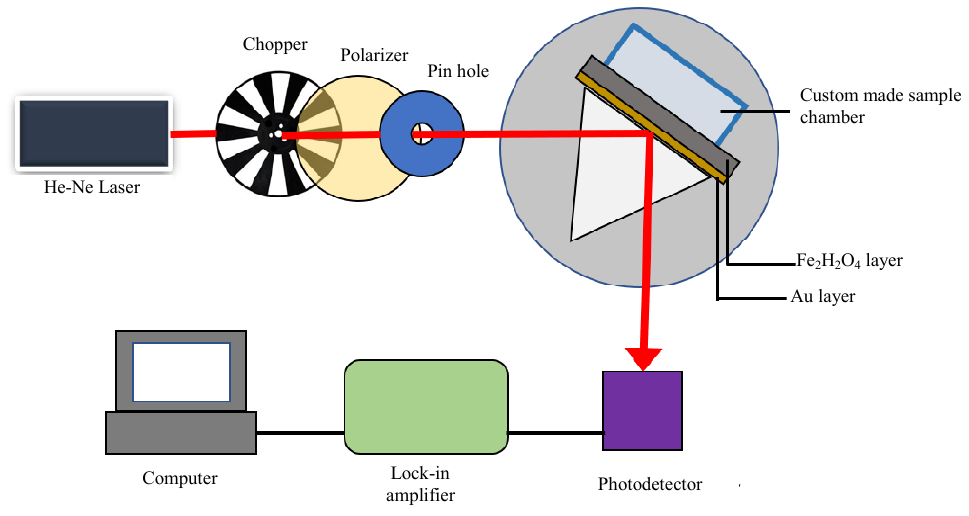
Fig. 1 Experimental setup of Au-Fe 2 H 2 O 4 sensing layer in prism-based Kretschmann configuration for As